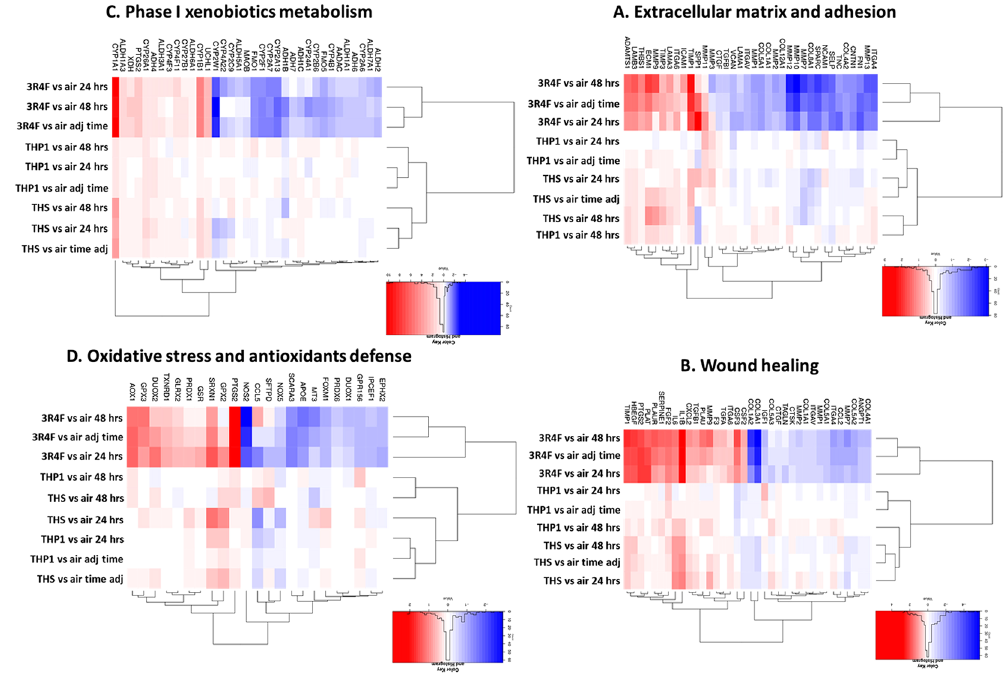
Figure 5. Unsupervised hierarchical clusters of genesets for extracellular matrix and adhesion ( A ) wound healing ( B ) phase I xenobiotic metabolism ( C ) oxidative stress and antioxidant response ( D ). Significant genes at pFDR < 0.05 and [FC] > 1.5 in at least one of the treatment. Contrasts are shown on the heat map with the log2(fold change) scale intensity. Blue indicates down-regulation and red indicates